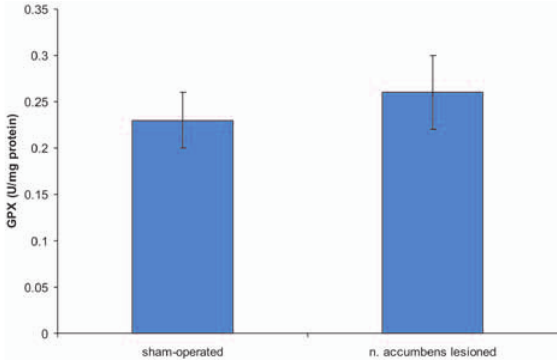
Figure 6. Effects of 6-OHDA-induced lesion of the NAcc on GPX specific activity from the temporal lobe. The values are mean ± SEM (n=6 animals per